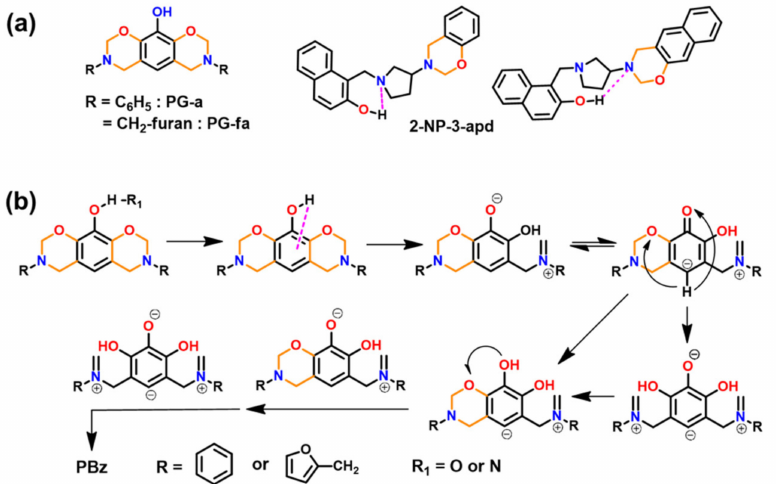
Figure 68. ( a ) Existence of polar phenolic-OH in benzoxazine monomer assisting ROP reaction.